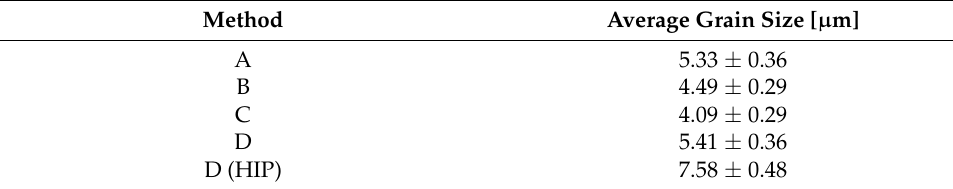
Table 3. Average grain size of materials sintered at 1400 ◦ C [34].